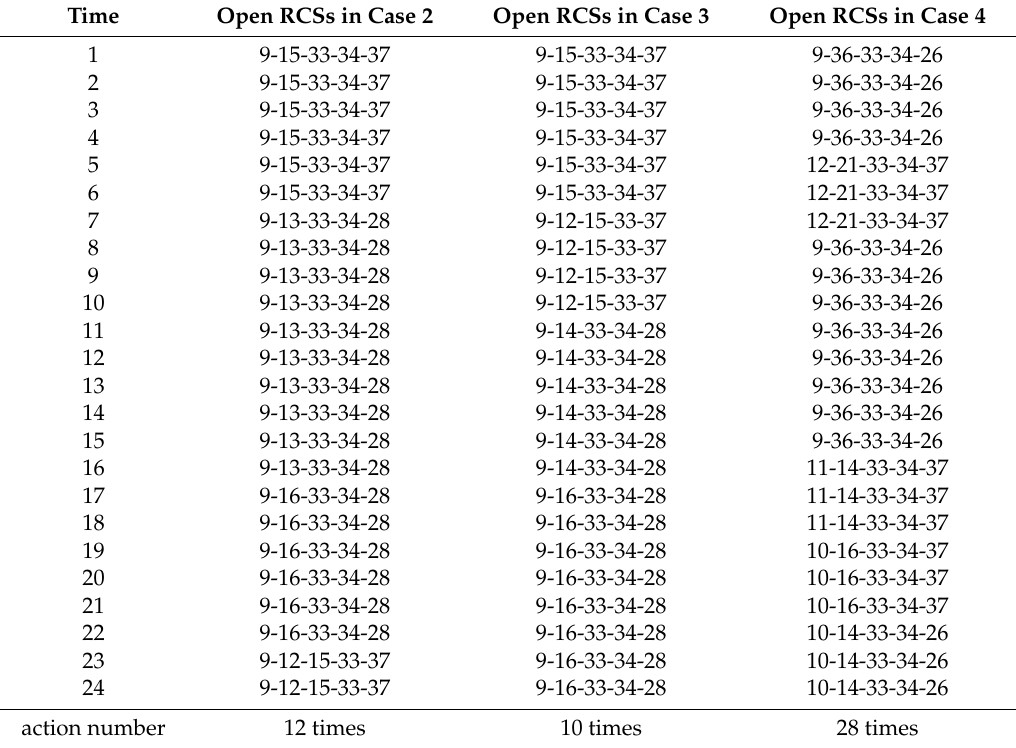
Table 2. Results of network reconfiguration.